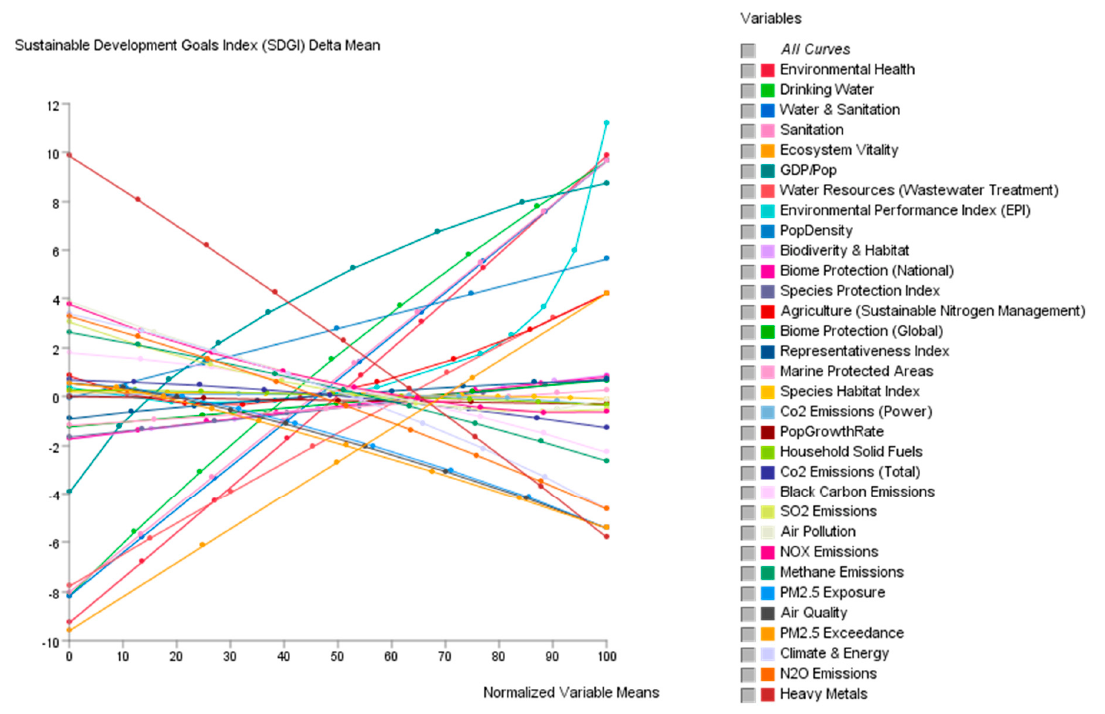
Figure 2. Target-mean analysis of the curves representing the parameters of environmental performance.